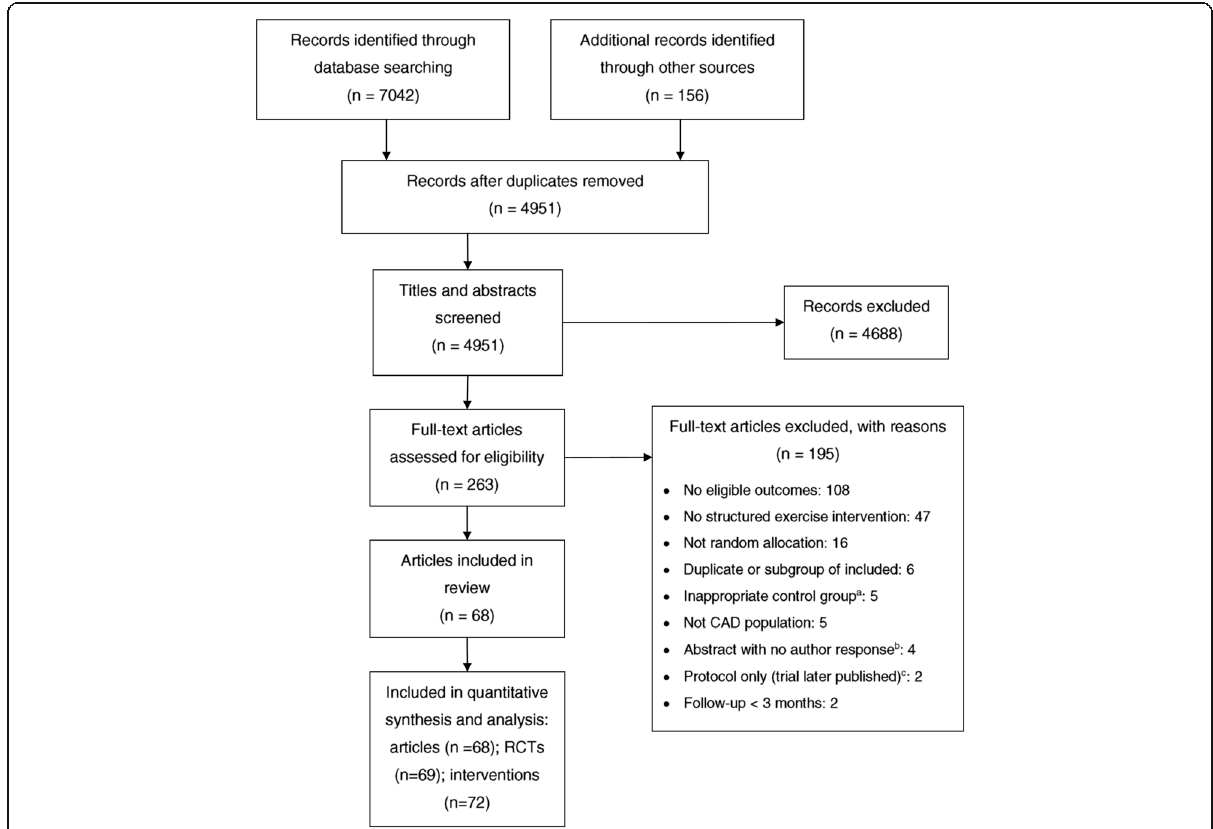
Fig. 1 PRISMA flow diagram of the screening and selection of trials. a Different type of exercise or surgical intervention as comparator. b We were unable to assess the eligibility of one trial published as a conference abstract as the author did not respond to repeated email inquiries. Two other conference abstracts described trials with outcomes eligible for inclusion; however, these could not be included as authors were not yet ready to share their results. One further abstract was eligible for inclusion; however, the author failed to respond to requests for data (abstract references in Additional file 1: Appendix S3). c One of these trials was later excluded and one included. CAD coronary artery disease,